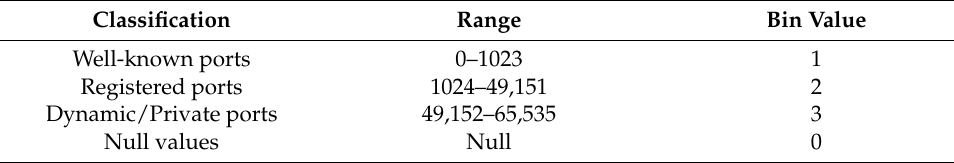
Table 9. Binning shown for port number